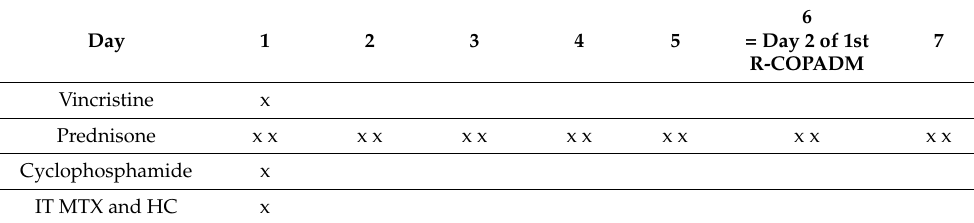
Table 2. Treatment according to the B-HR arm of the Inter-B-NHL-COP 2010 with dose reduction